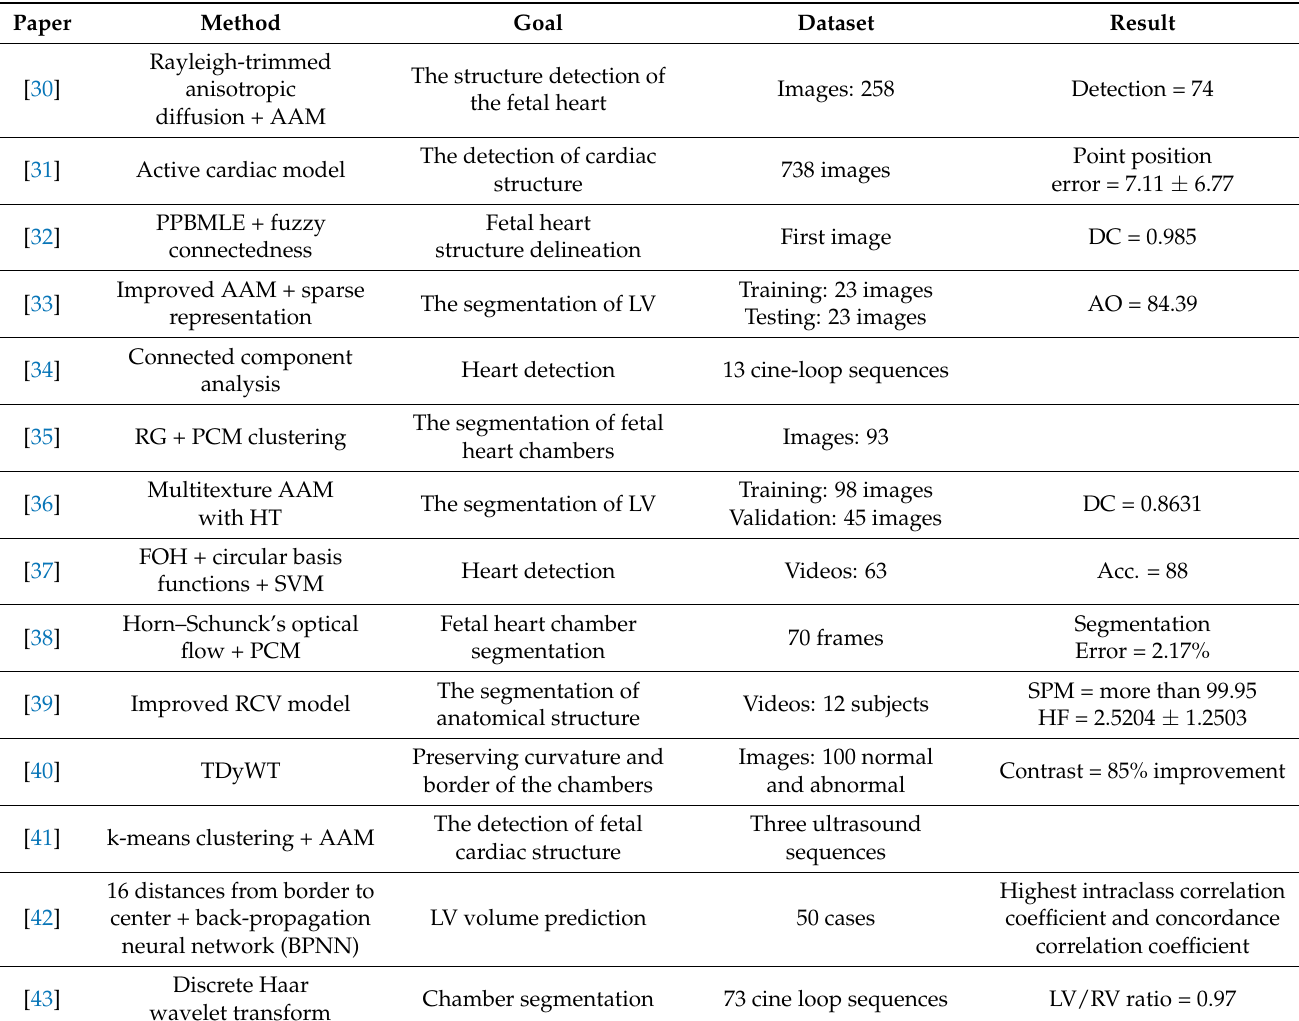
Table 1. Nondeep learning segmentation techniques for fetal heart ultrasound images and